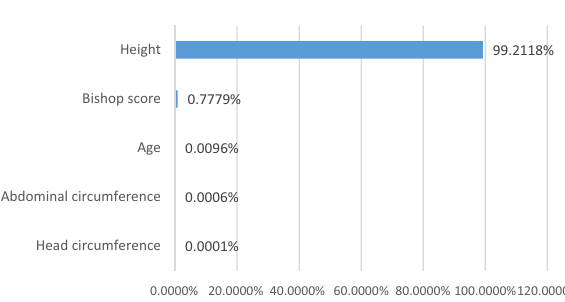
Figure 4. Ranking of the variables of logistic regression model of